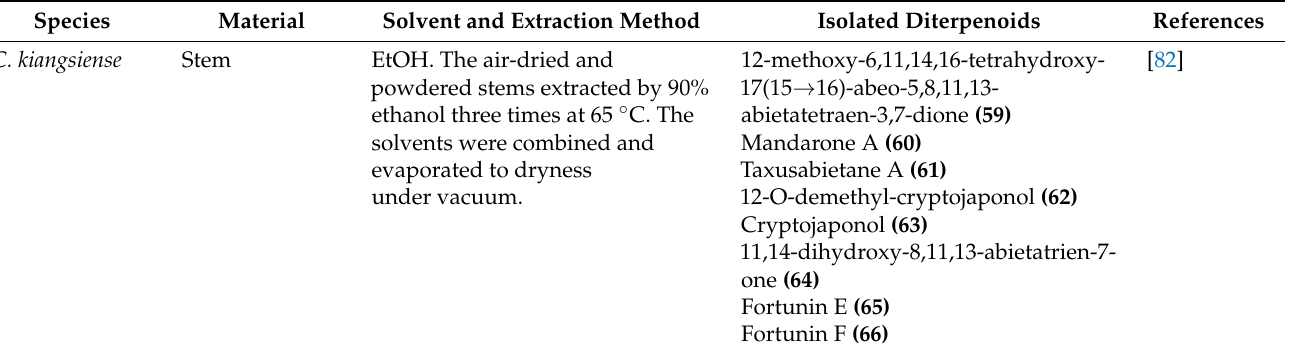
Table 8. The diterpenoid extraction method and C. kiangsiense plant material for diterpenoid isolation.